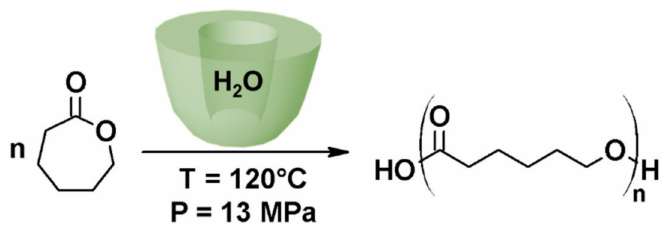
Figure 9. A “chemzyme”, based on native β -CD, that mimics the mode of action of a lipase under high-pressure conditions. P, pressure.